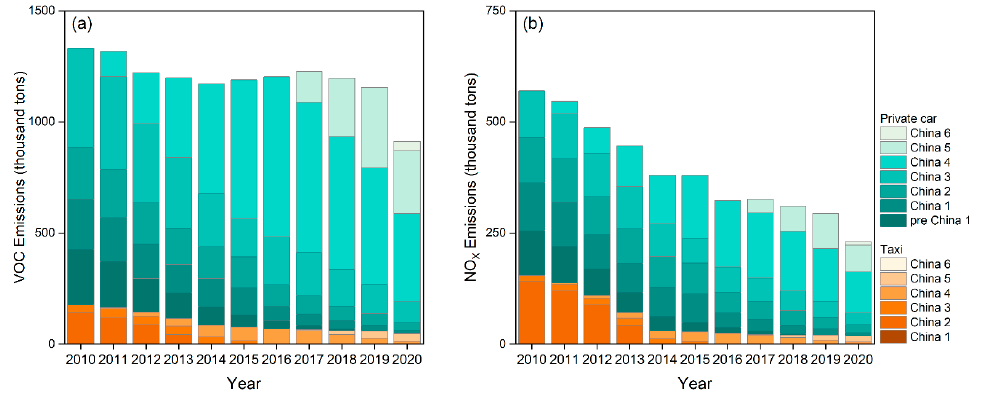
Figure 7. ( a ) VOC and ( b ) NO X emissions of LDPV from 2010 to 2020. Vehicular emissions account for a major part of anthropogenic VOC and NO X emissions [24], which are important precursors for secondary organic aerosols (SOA),